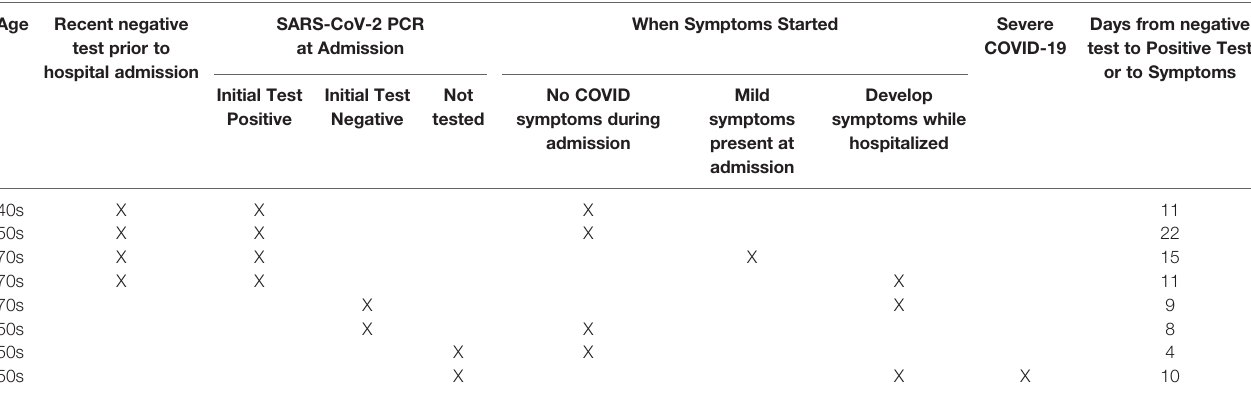
TABLE 1 | Incidental Patient data to calculate mean time to positive PCR test. Age Recent negative test prior